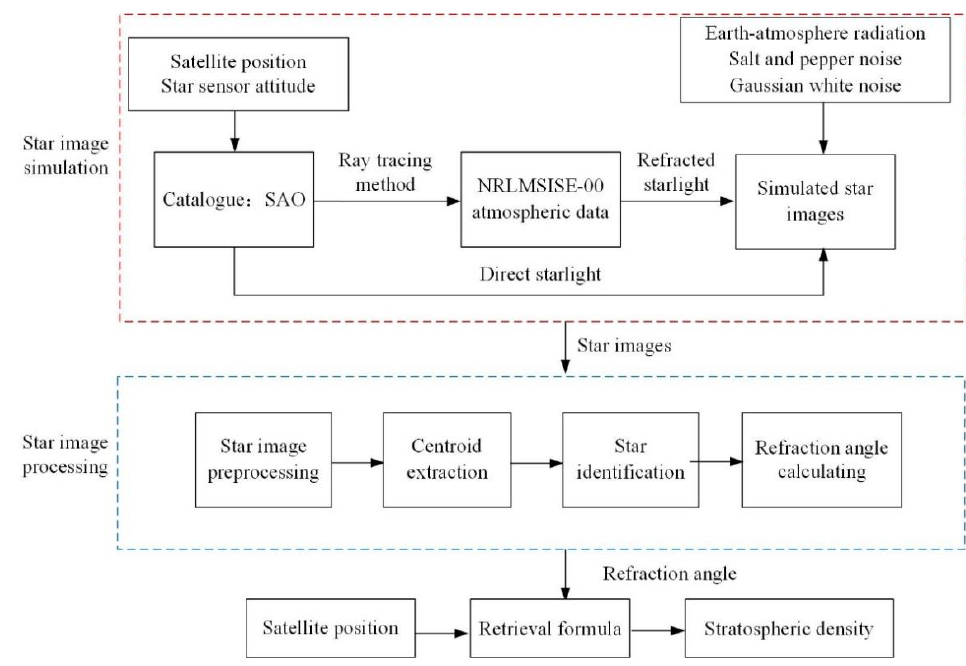
Figure 14. The flowchart of the simulations.